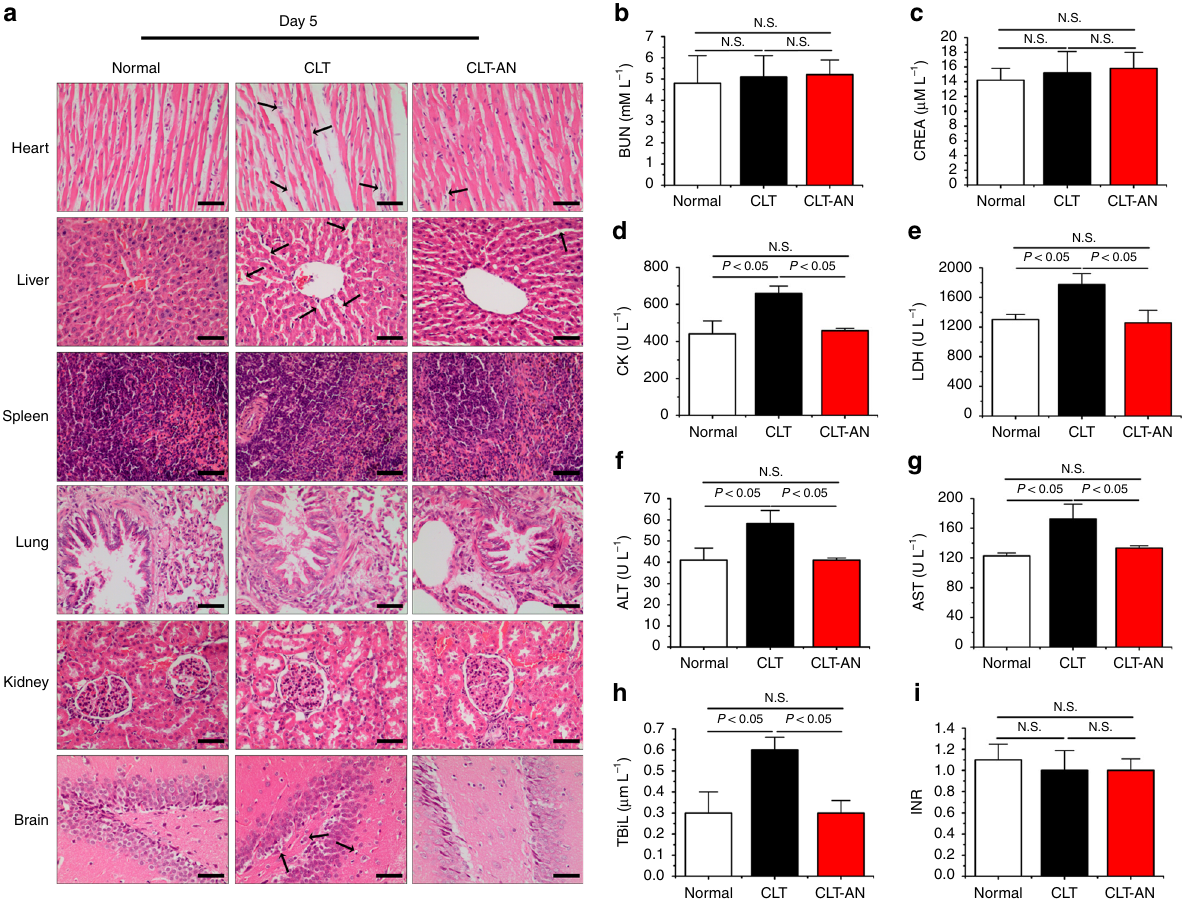
Fig. 9 CLT-AN reduces systemic toxicity of CLT in rats. a Hematoxylin & eosin (H&E) staining assay of heart, liver, spleen, lung, kidney, and brain on day 5 after CLT or CLT-AN treatment. Black arrows in heart samples indicate atrophy of myocardial cells and myo fi brillar loss; arrows in liver samples indicate atrophy of hepatic cells and dilatation of blood sinus; and arrows in brain samples indicate pyknosis of neuron and red neurons. Scale bars , 50 μ m. b – i BUN, CREA, CK, LDH, ALT, AST, TBiL, and INR levels on day 5 after CLT or CLT-AN treatment. Data are mean ± s.d. ( n = 5), results are representative of two independent experiments. Statistical signi fi cance was determined by one-way ANOVA with Tukey post hoc test. N.S., not signi fi